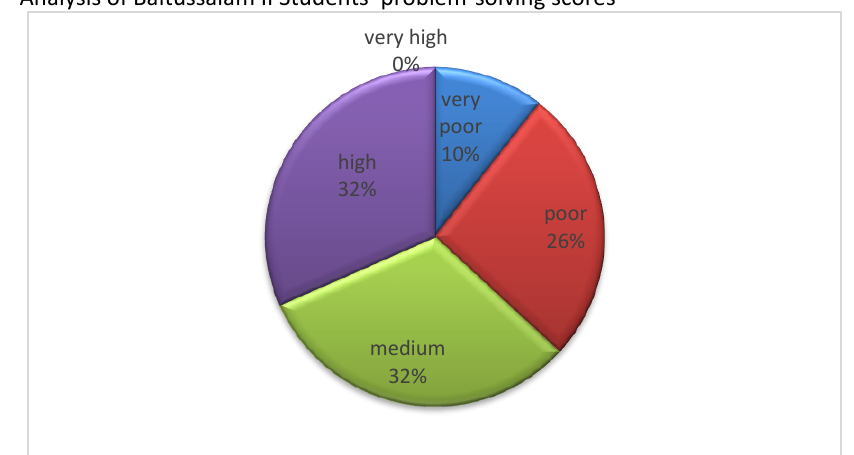
Figure 8. Baitussalam II Students’ HOTS based on Problem-Solving Indicator in